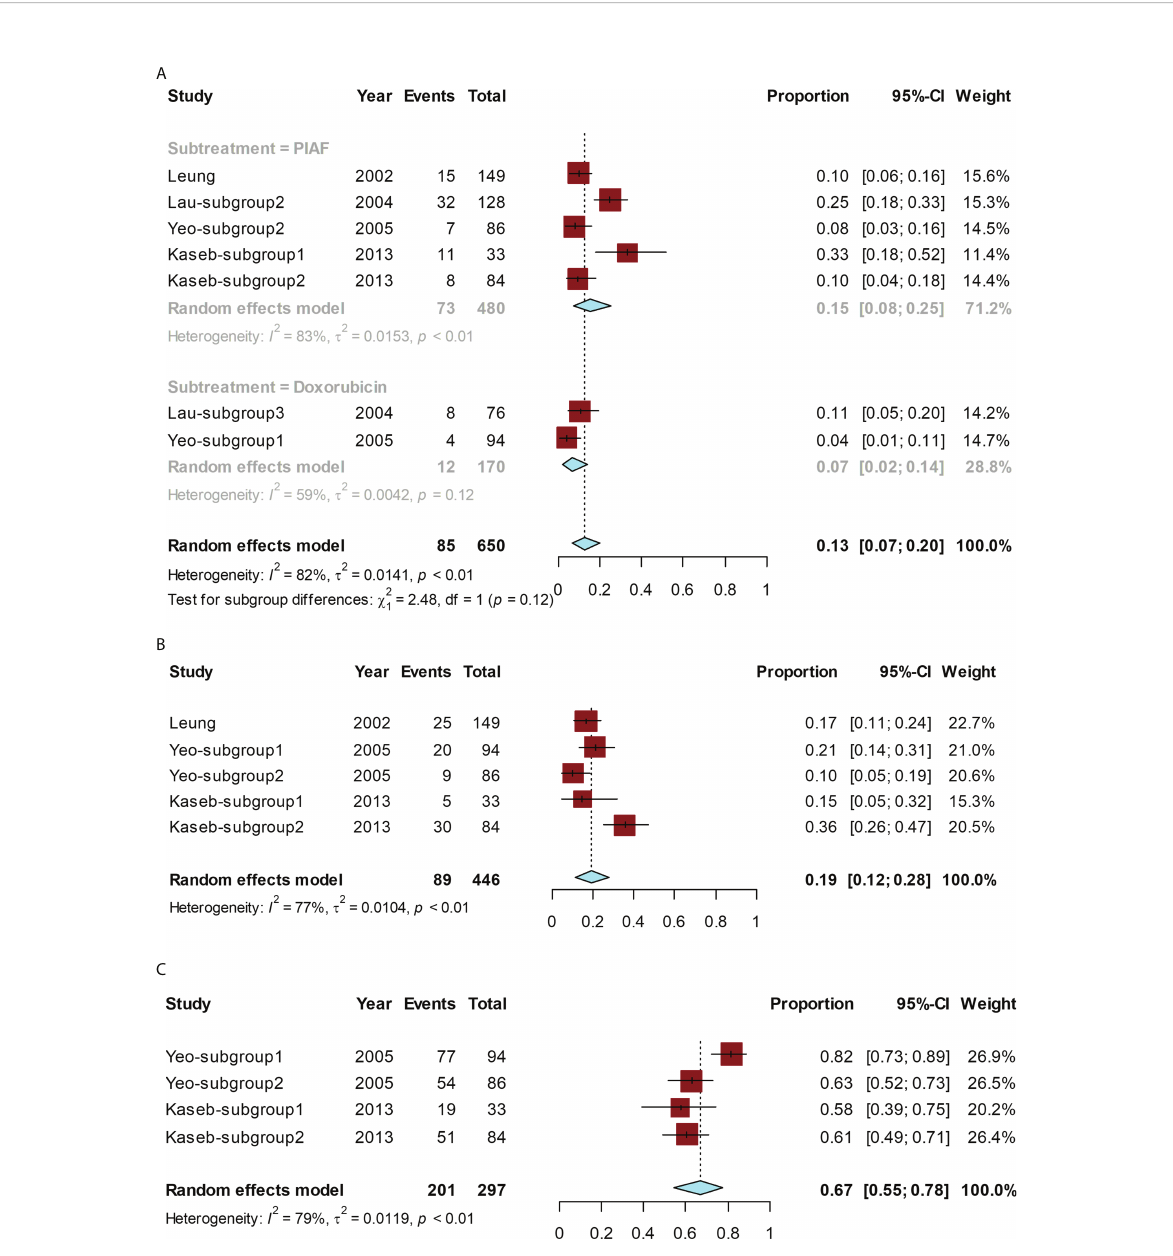
FIGURE 2 Forest plot for the chemotherapy group. The pooled conversion rate and subgroup analysis of the conversion rate according to PIAF or doxorubicin (A) , pooled ORR (B) , and the pooled rate of grade ≥ 3 AEs (C)